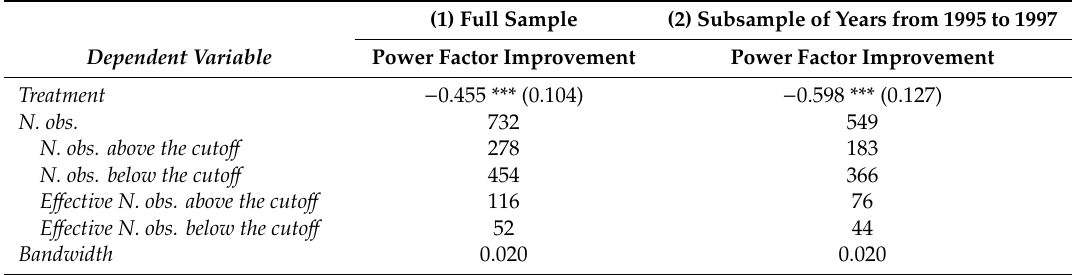
Table 2. Sharp regression discontinuity design (RDD) estimation